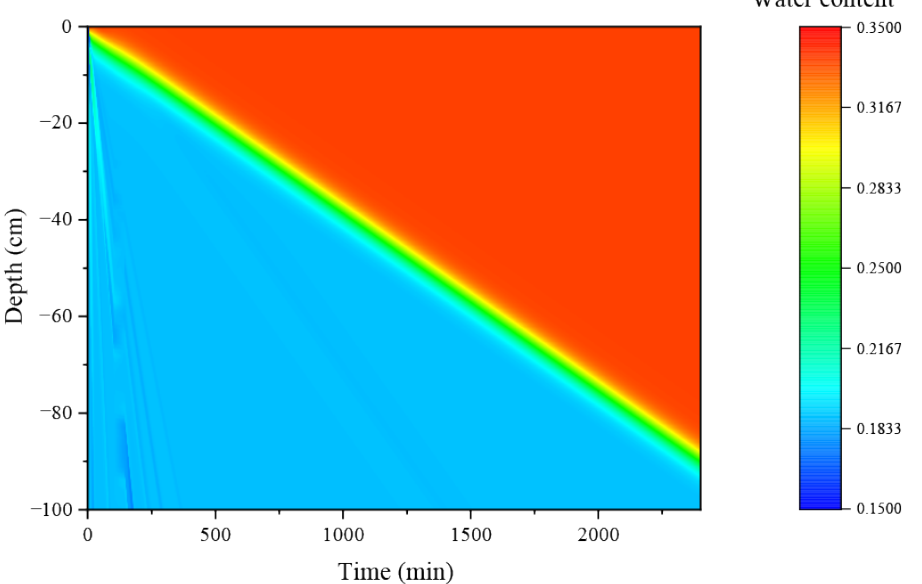
Figure 11. The results of the numerical prediction of soil–water infiltration in light-loam soils over